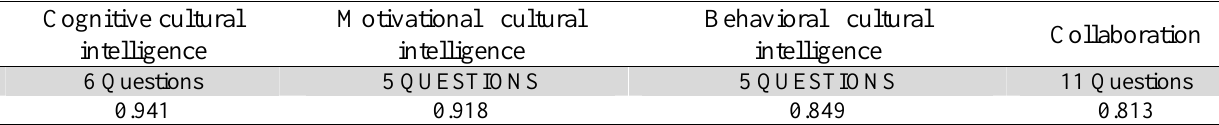
Reliability tests of the questionnaires, with Cronbach alpha coefficient